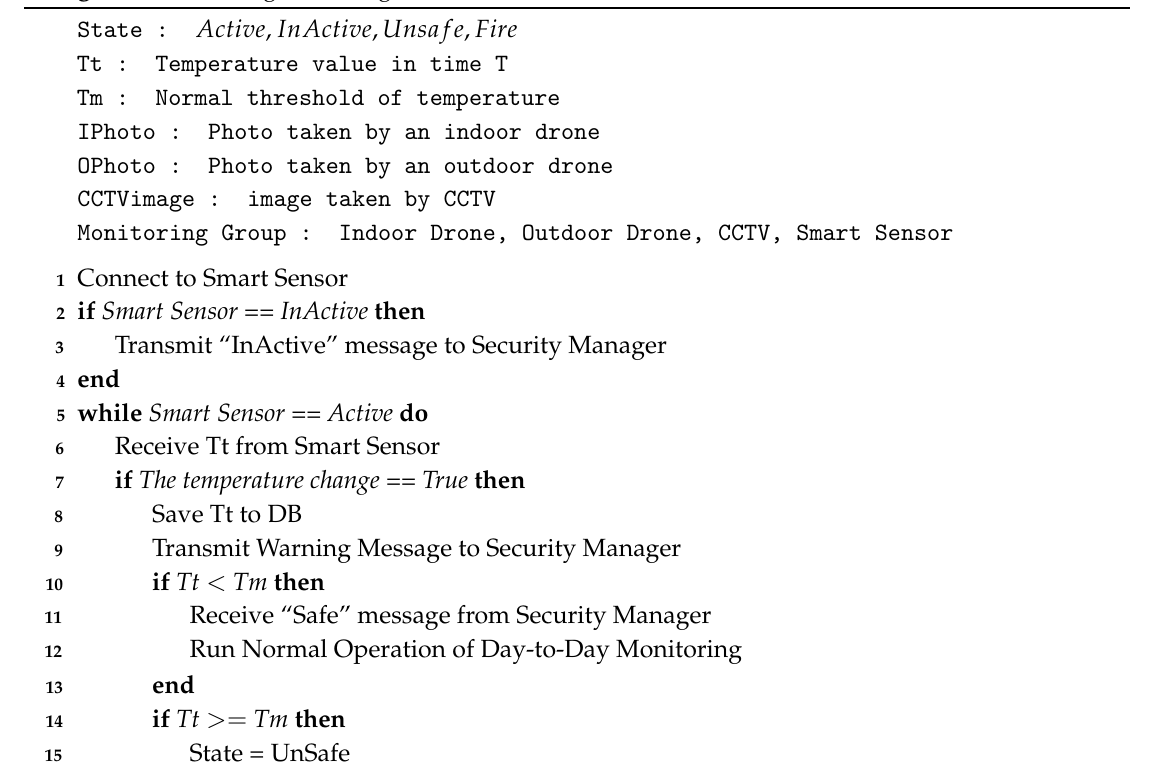
Algorithm 1: Management Algorithm of Control